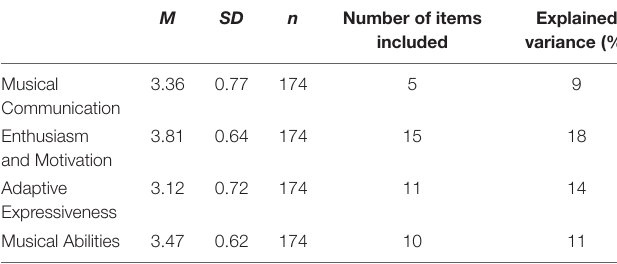
TABLE 4 | Mean ratings grouped by